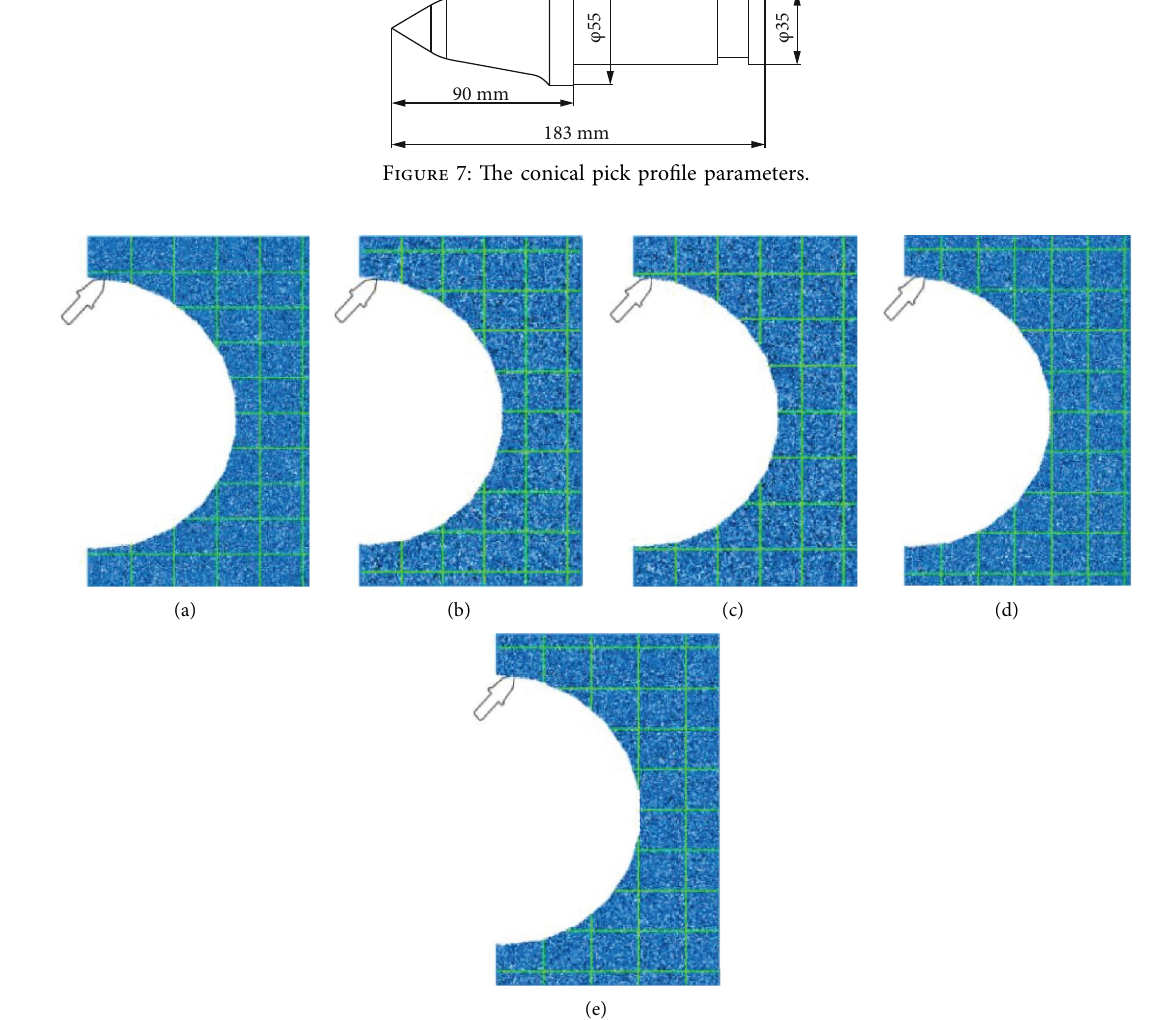
Figure 8: The PFC model of the conical pick cutting